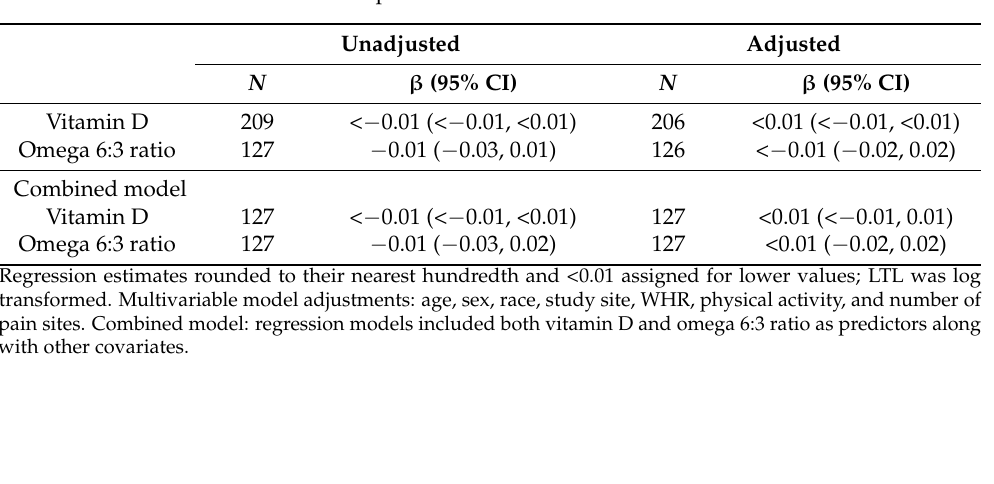
Table 2. Associations between selected serum micronutrients and leukocyte telomere length in individuals with and without chronic pain. Unadjusted